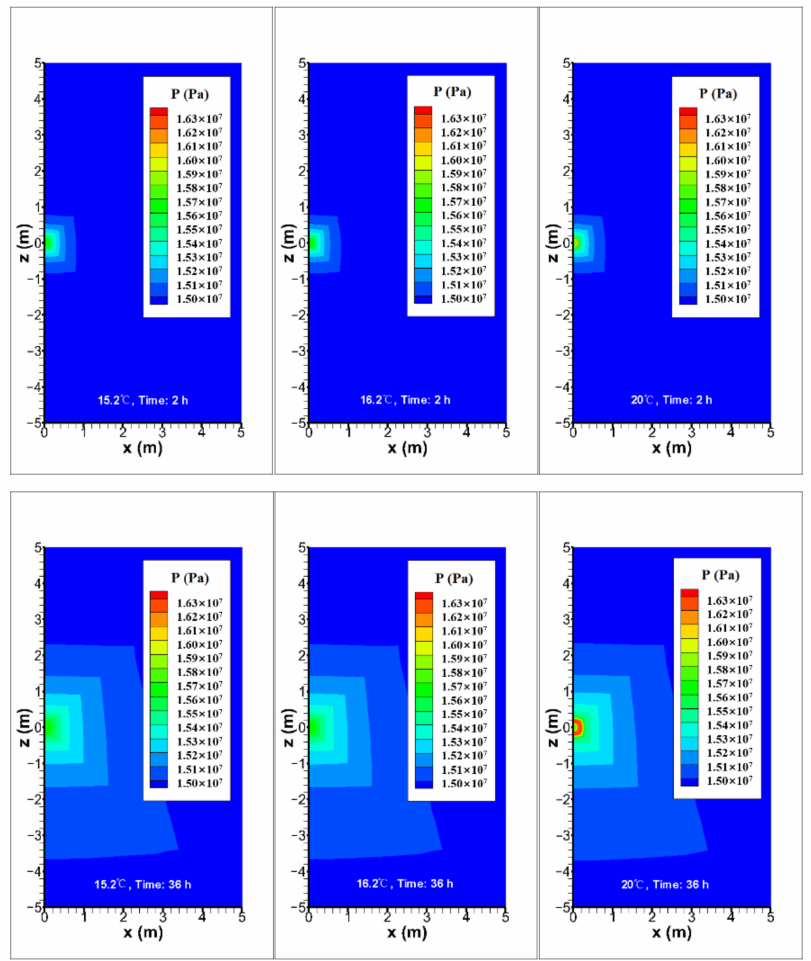
Figure 6. Pore pressure distribution evolution of the near-wellbore reservoir with different tempera- tures of drilling